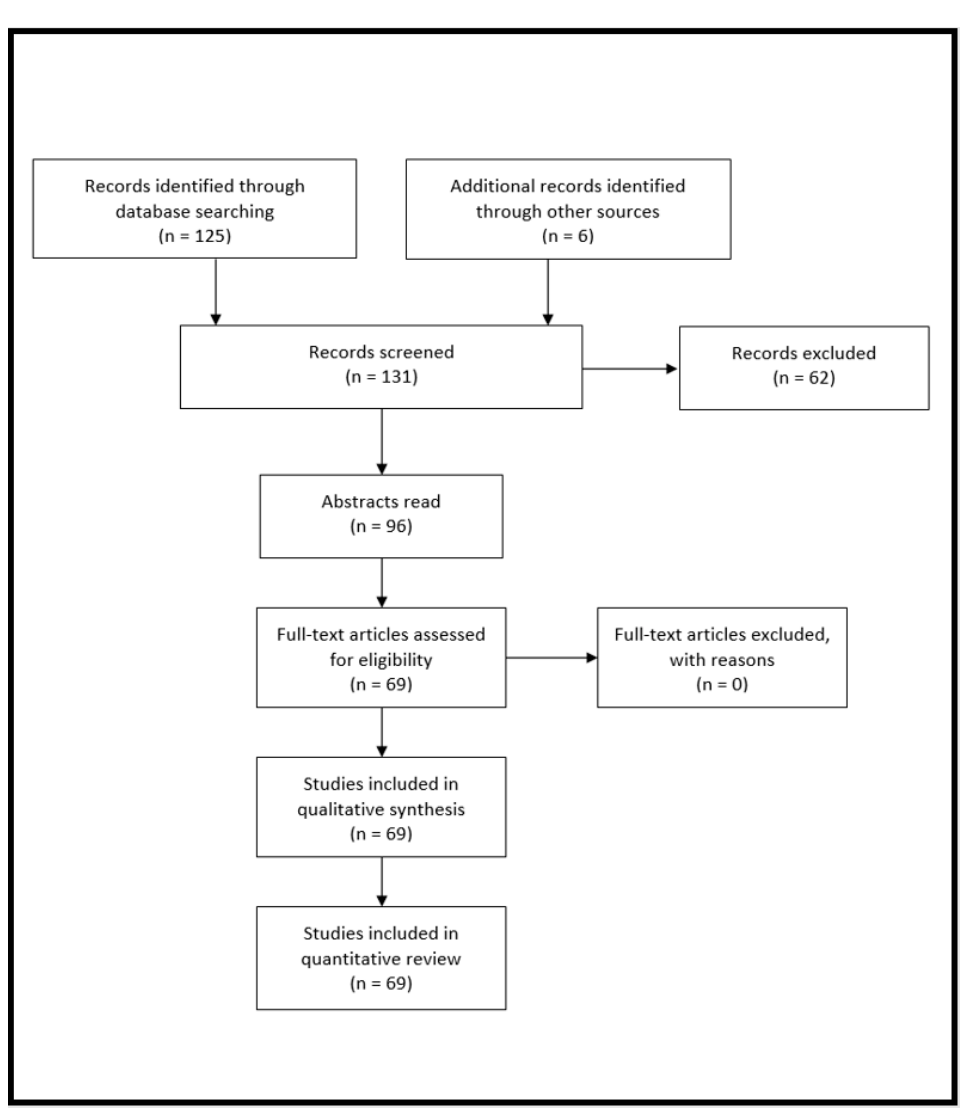
Figure A1. Flow diagram of the database search, screening, and inclusion of the studies (modified after the Preferred Reporting Items for Systematic Reviews and Meta-Analyses (PRISMA) guidelines [10]).